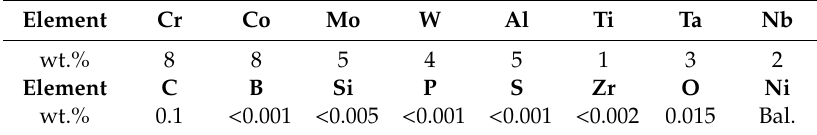
Table 1. The chemical composition of the MAD542 nickel-based superalloy investigated in this study. Element Cr Co Mo W Al